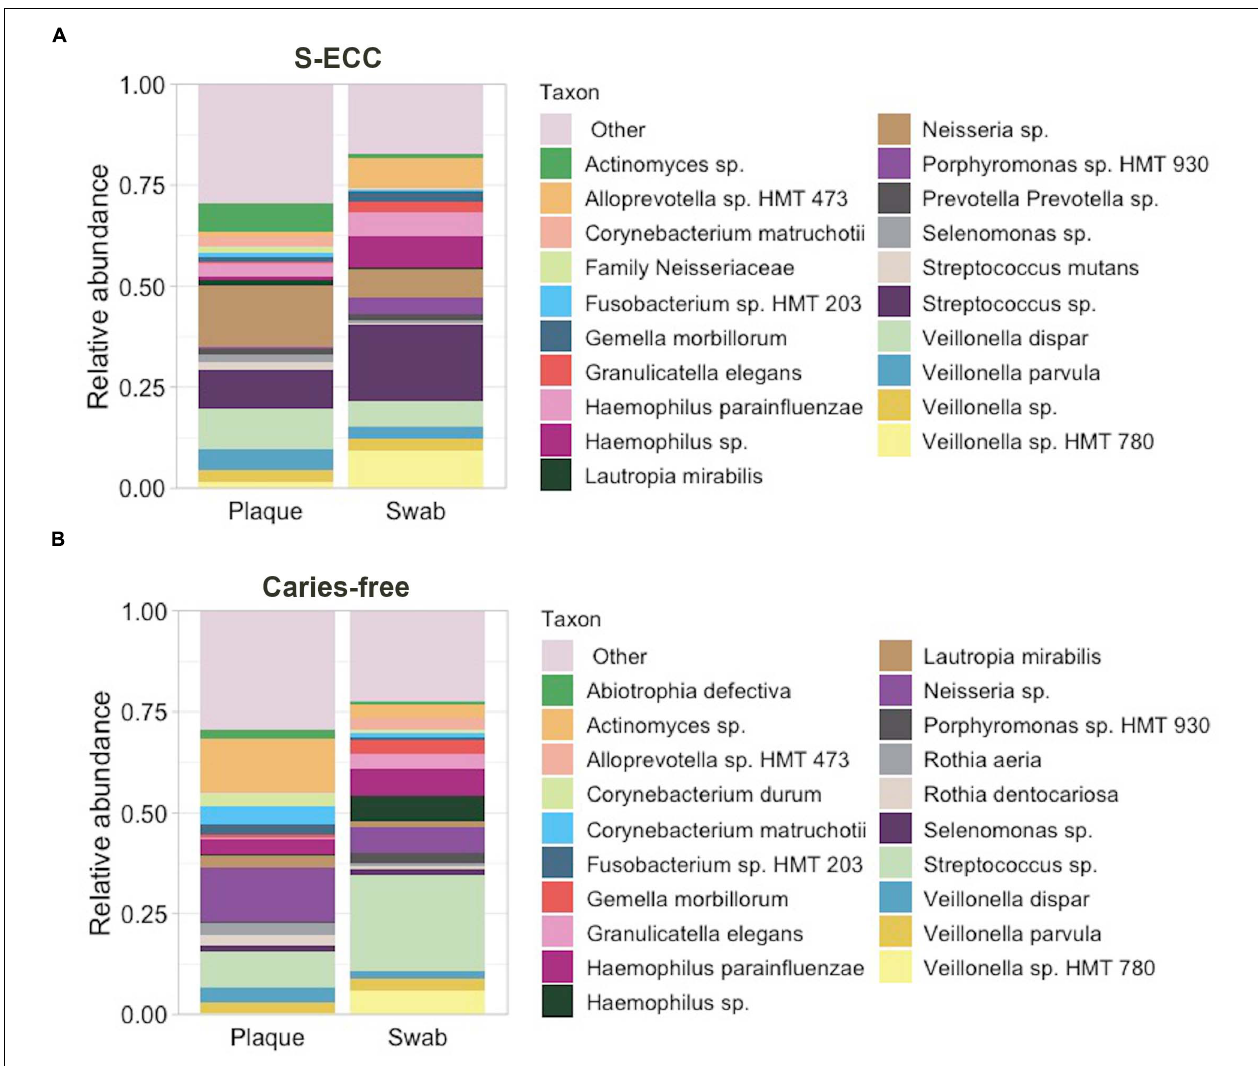
FIGURE 1 | Bacterial taxonomic profiles of dental plaque and oral swab. Relative abundance of the top 20 bacterial taxa in dental plaque and oral swab samples from (A) children with S-ECC and (B) caries-free children. “Other” indicates the taxa not individually shown. S-ECC, severe early childhood caries.